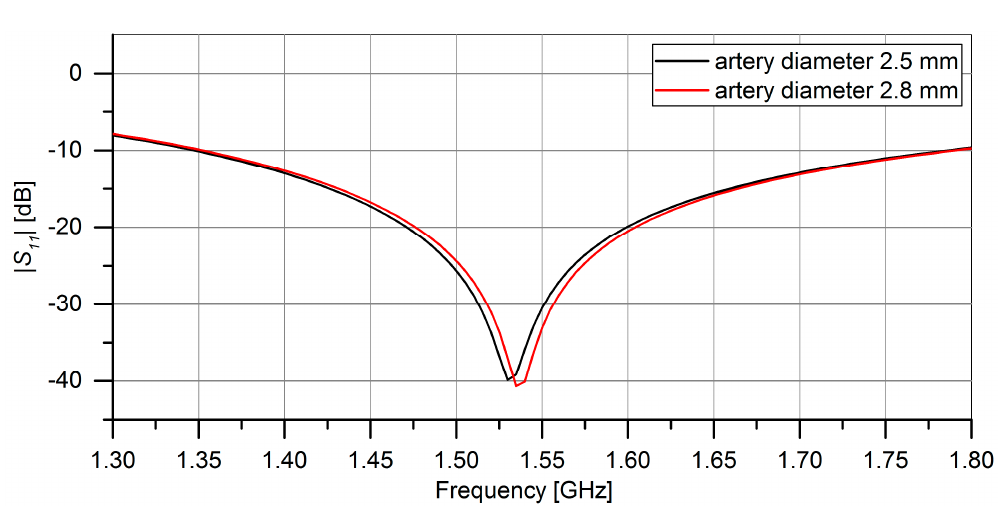
Figure 3. CST Microwave Studio Simulation results for the impact of different artery diameters on the resonance of the symmetrical split-ring resonator. In black: ∅ artery = 2.5 mm. In red: ∅ artery = 2.8 mm.